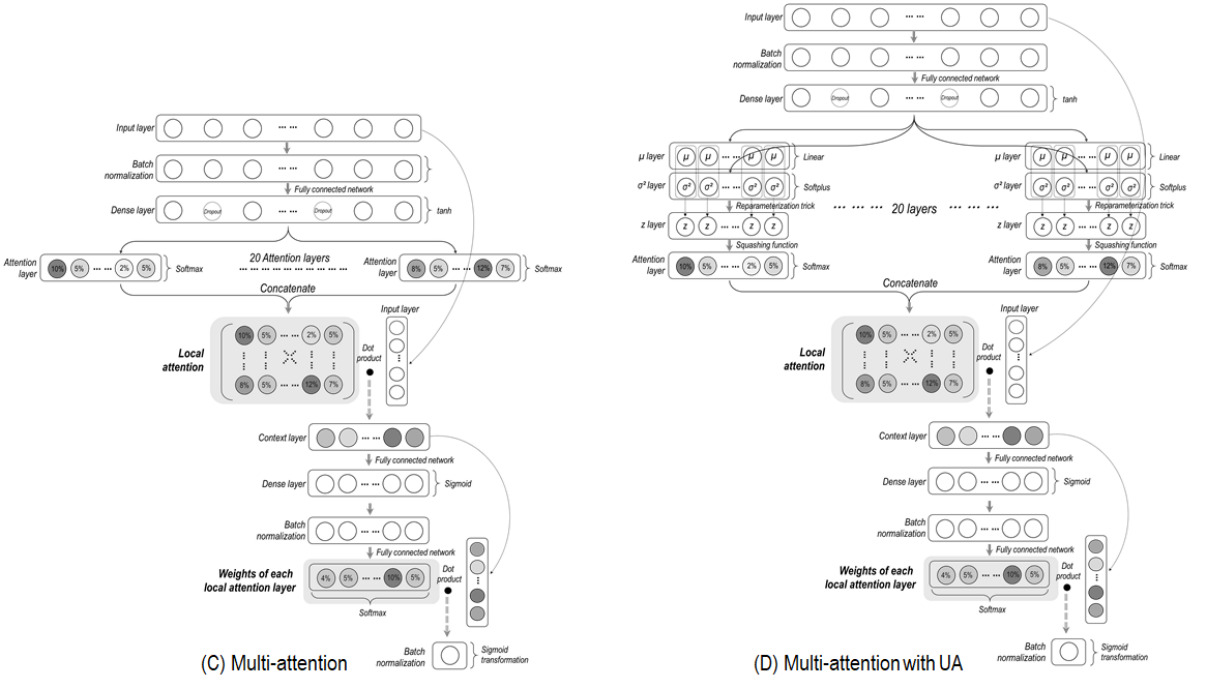
Figure 4. Model designs for multi-attention mechanisms. UA: uncertainty awareness. The concept of "reparameterization trick" is described in Concept A1 of Multimedia Appendix